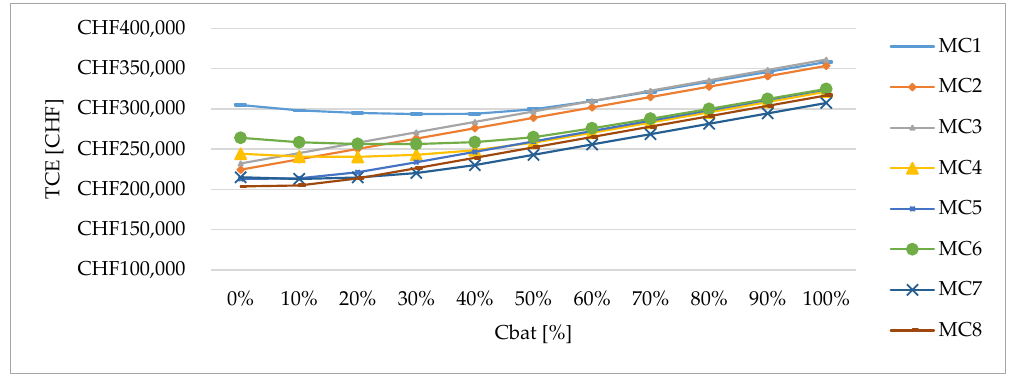
Figure 12. Comparison between the capacity of the storage system and the TCE for the MC.